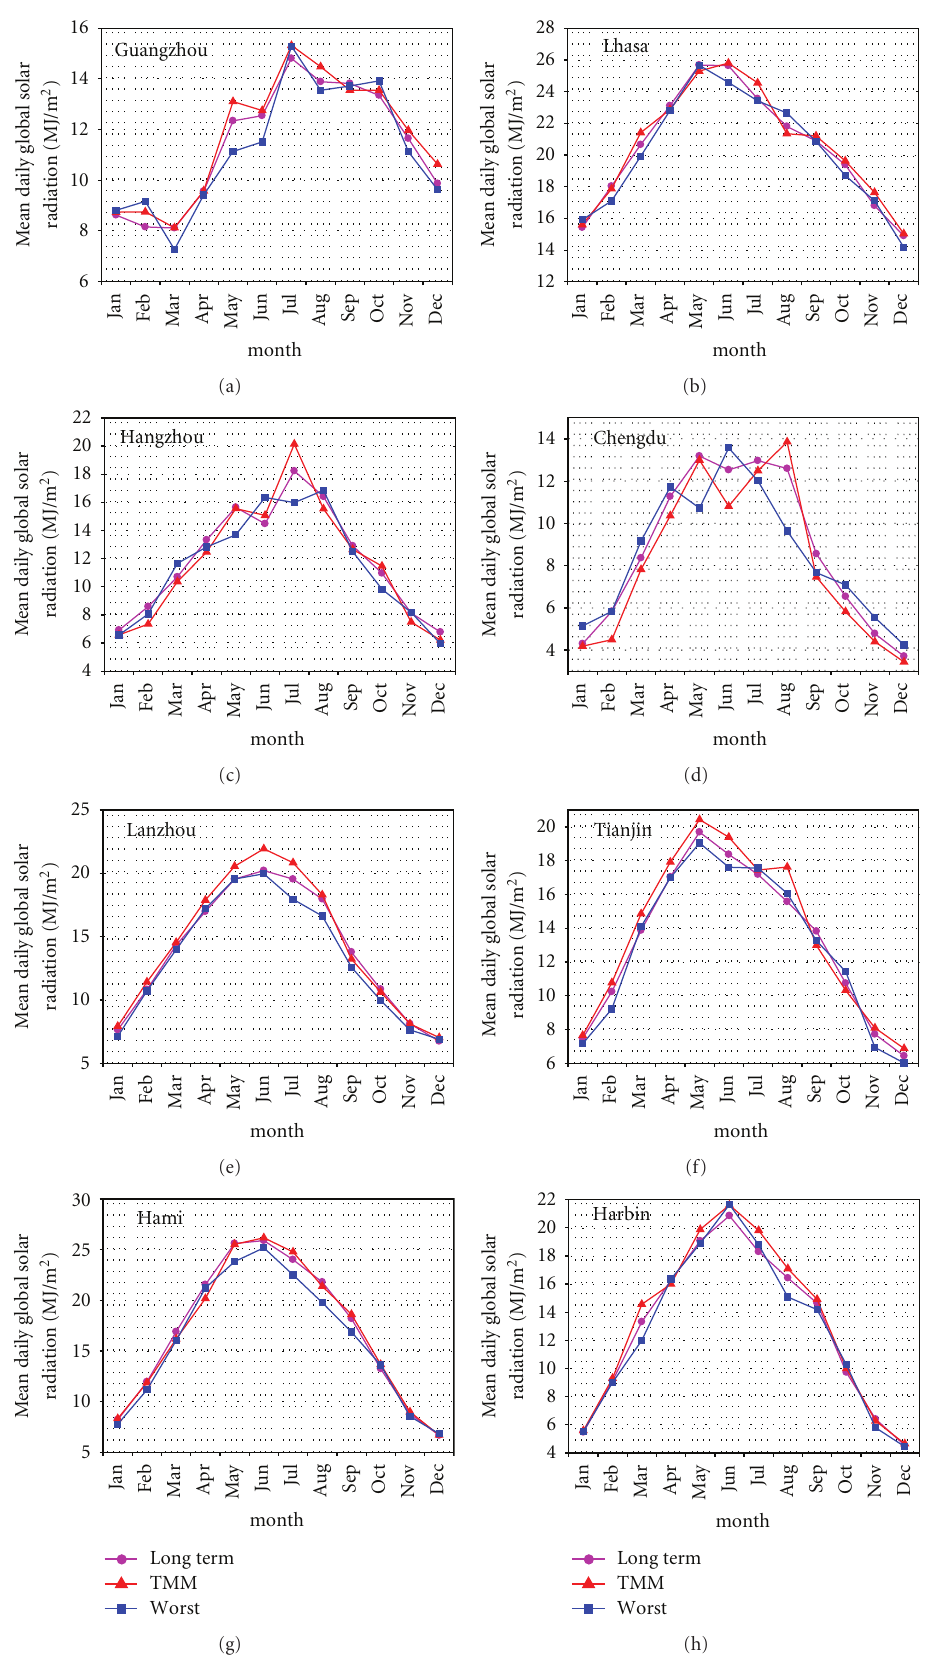
Figure 7: Monthly mean daily global solar radiation for the long-term, for the selected TMMs, and for the worst months at eight